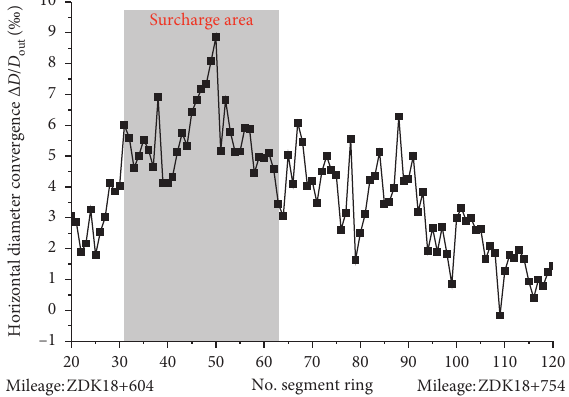
Figure 21: Diameter convergence of segment rings through on-site measurement.